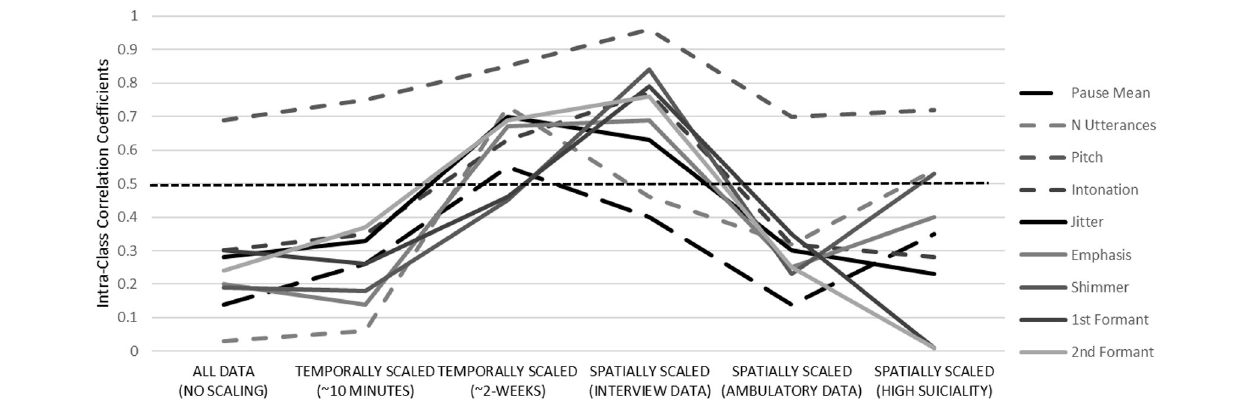
FIGURE 2 | Temporal stability of acoustic features across a variety temporal and spatial resolutions. Dotted midline reflects “fair” stability, defined at 0.50. See Table 2 for